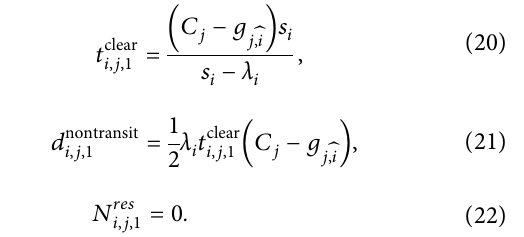
Figure 4: State transition diagram of the fnite state